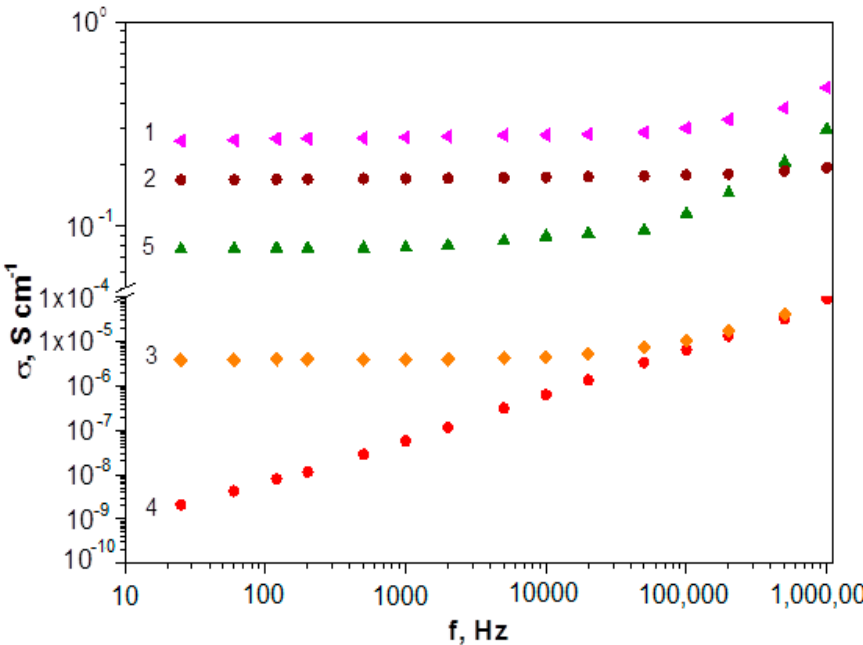
Figure 14. Current frequency dependence of conductivity: poly-DADCB (1), PANI (2), poly-DPDCB (3), poly-MADCB (4), poly-ASADCB (5).